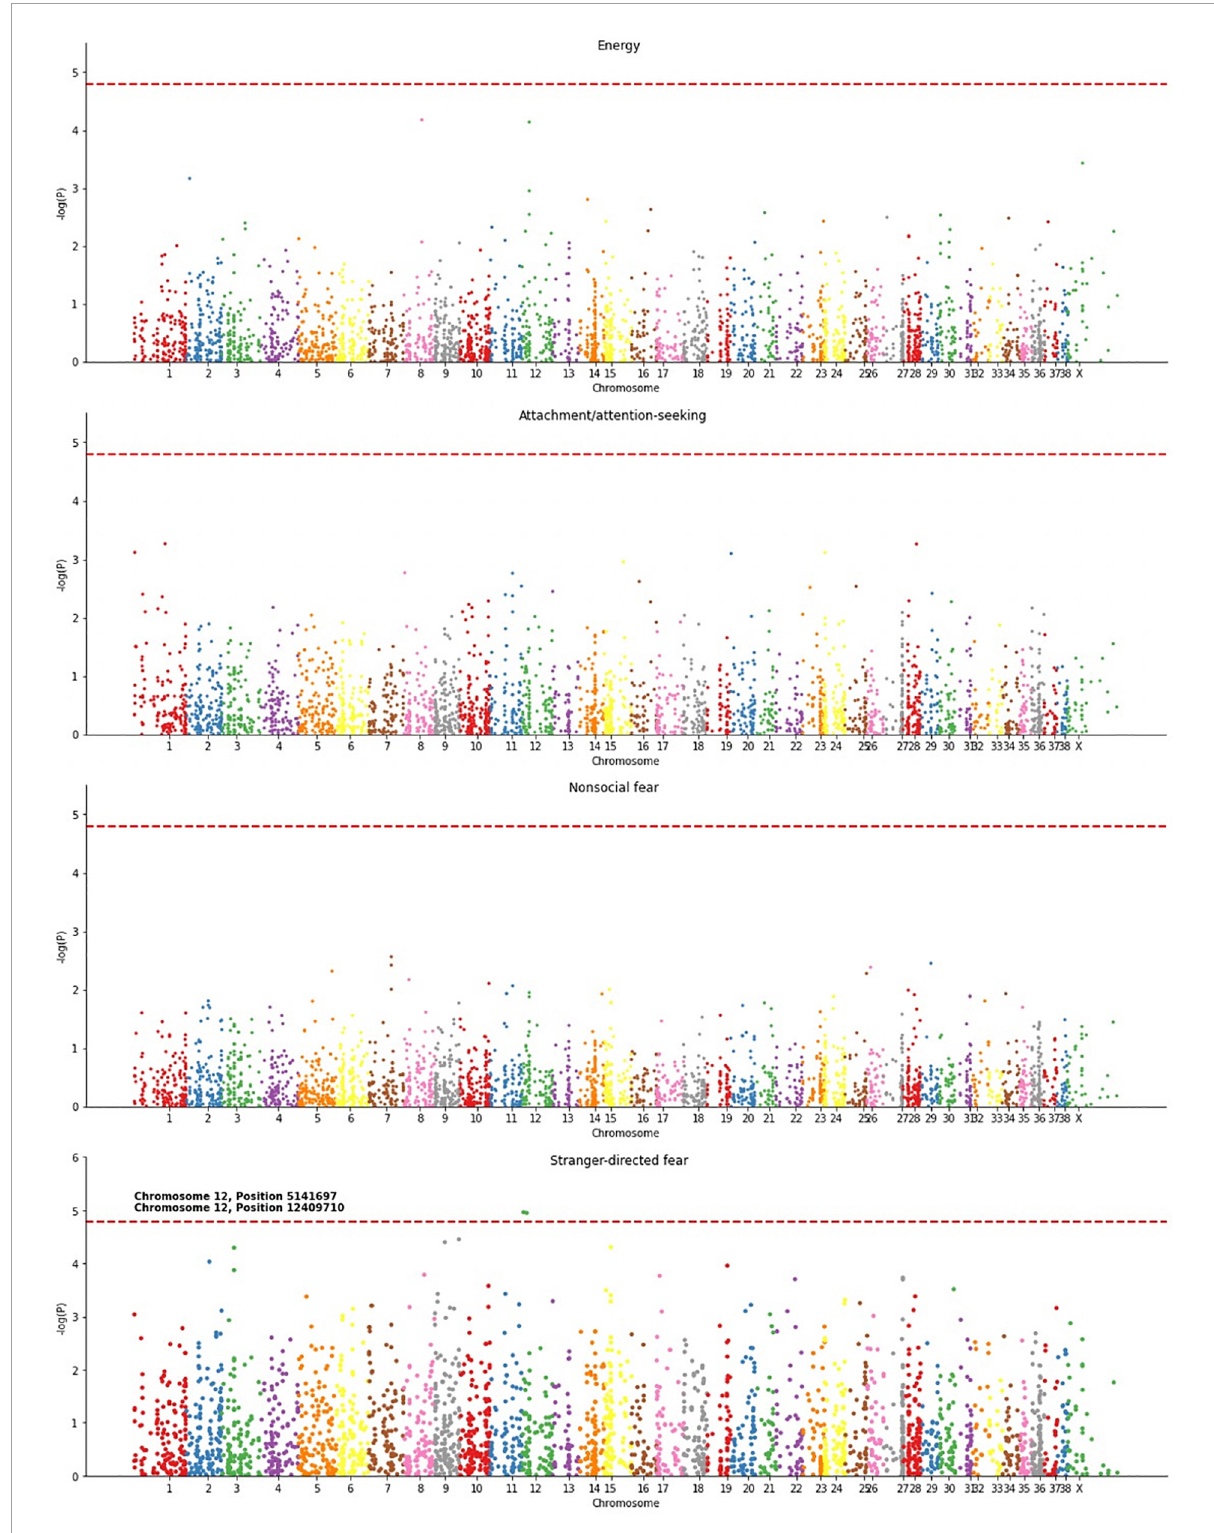
FIGURE4 Manhattan plots for energy, attachment/attention-seeking, non-social fear, and stranger-directed fear. P -values, associated with an individual loci’s methylation and statistical significance in predicting behavior, were calculated using OLS Regression from StatsModel (Seabold and Perktold, 2010). Significant loci were determined using a Bonferroni threshold, enlarged, and